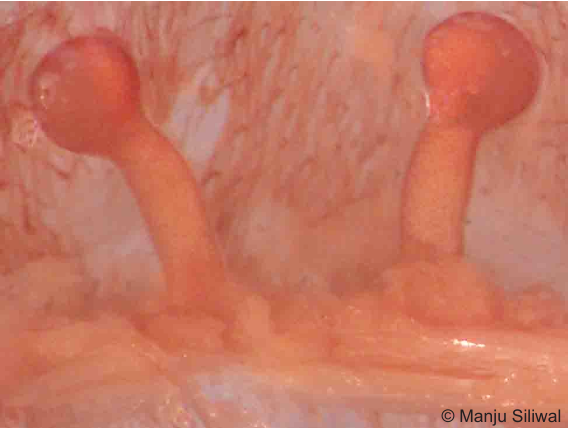
Image 9. Plesiophrictus mahabaleshwari , spermathecae, dorsal view Tikader, 1977 (ZSIK, Type, number not